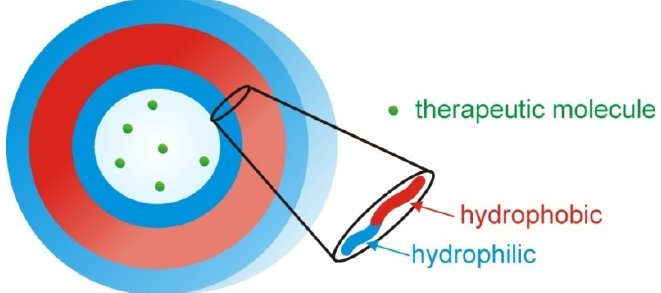
Figure 8. Polymersome formed by an amphiphilic diblock